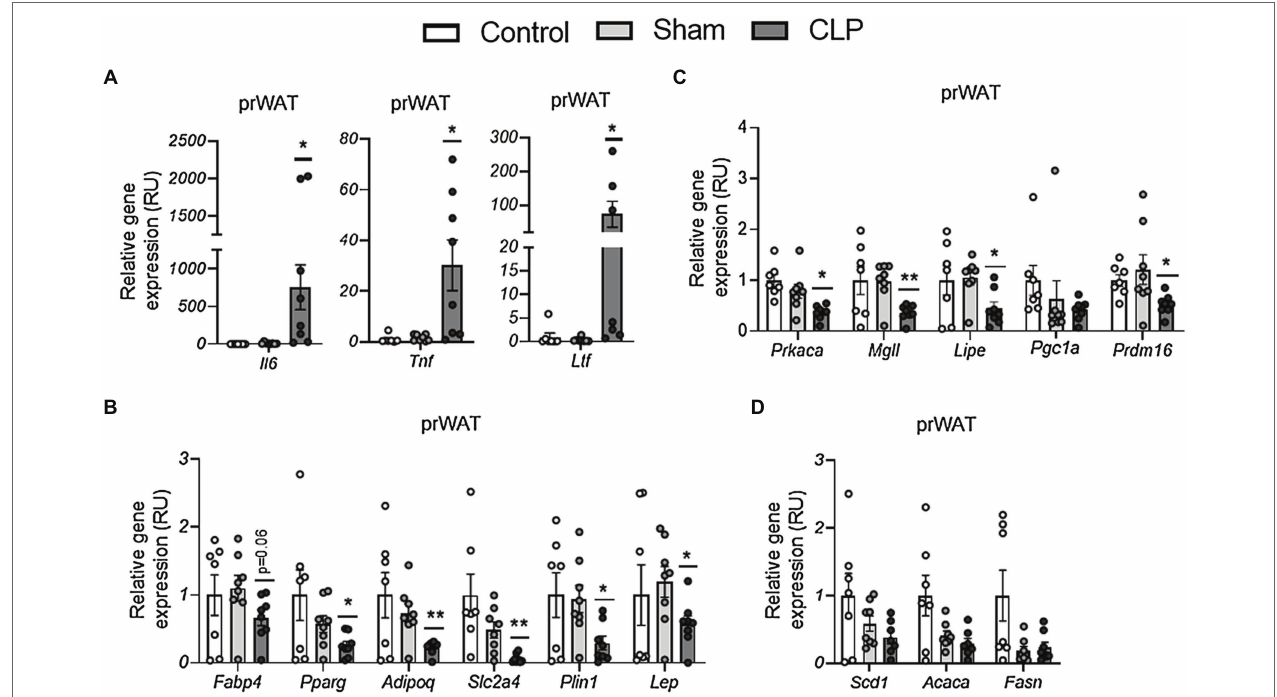
FIGURE 2 | (A–C) The effects of CLP-induced sepsis on expression of inflammation (A) , adipogenesis (B) , lipolytic/browning (C) , and lipogenesis (D) in prWAT, . CLP: cecal ligation and puncture. * p < 0.05 and ** p < 0.01 compared to sham, n = 7–8 mice per